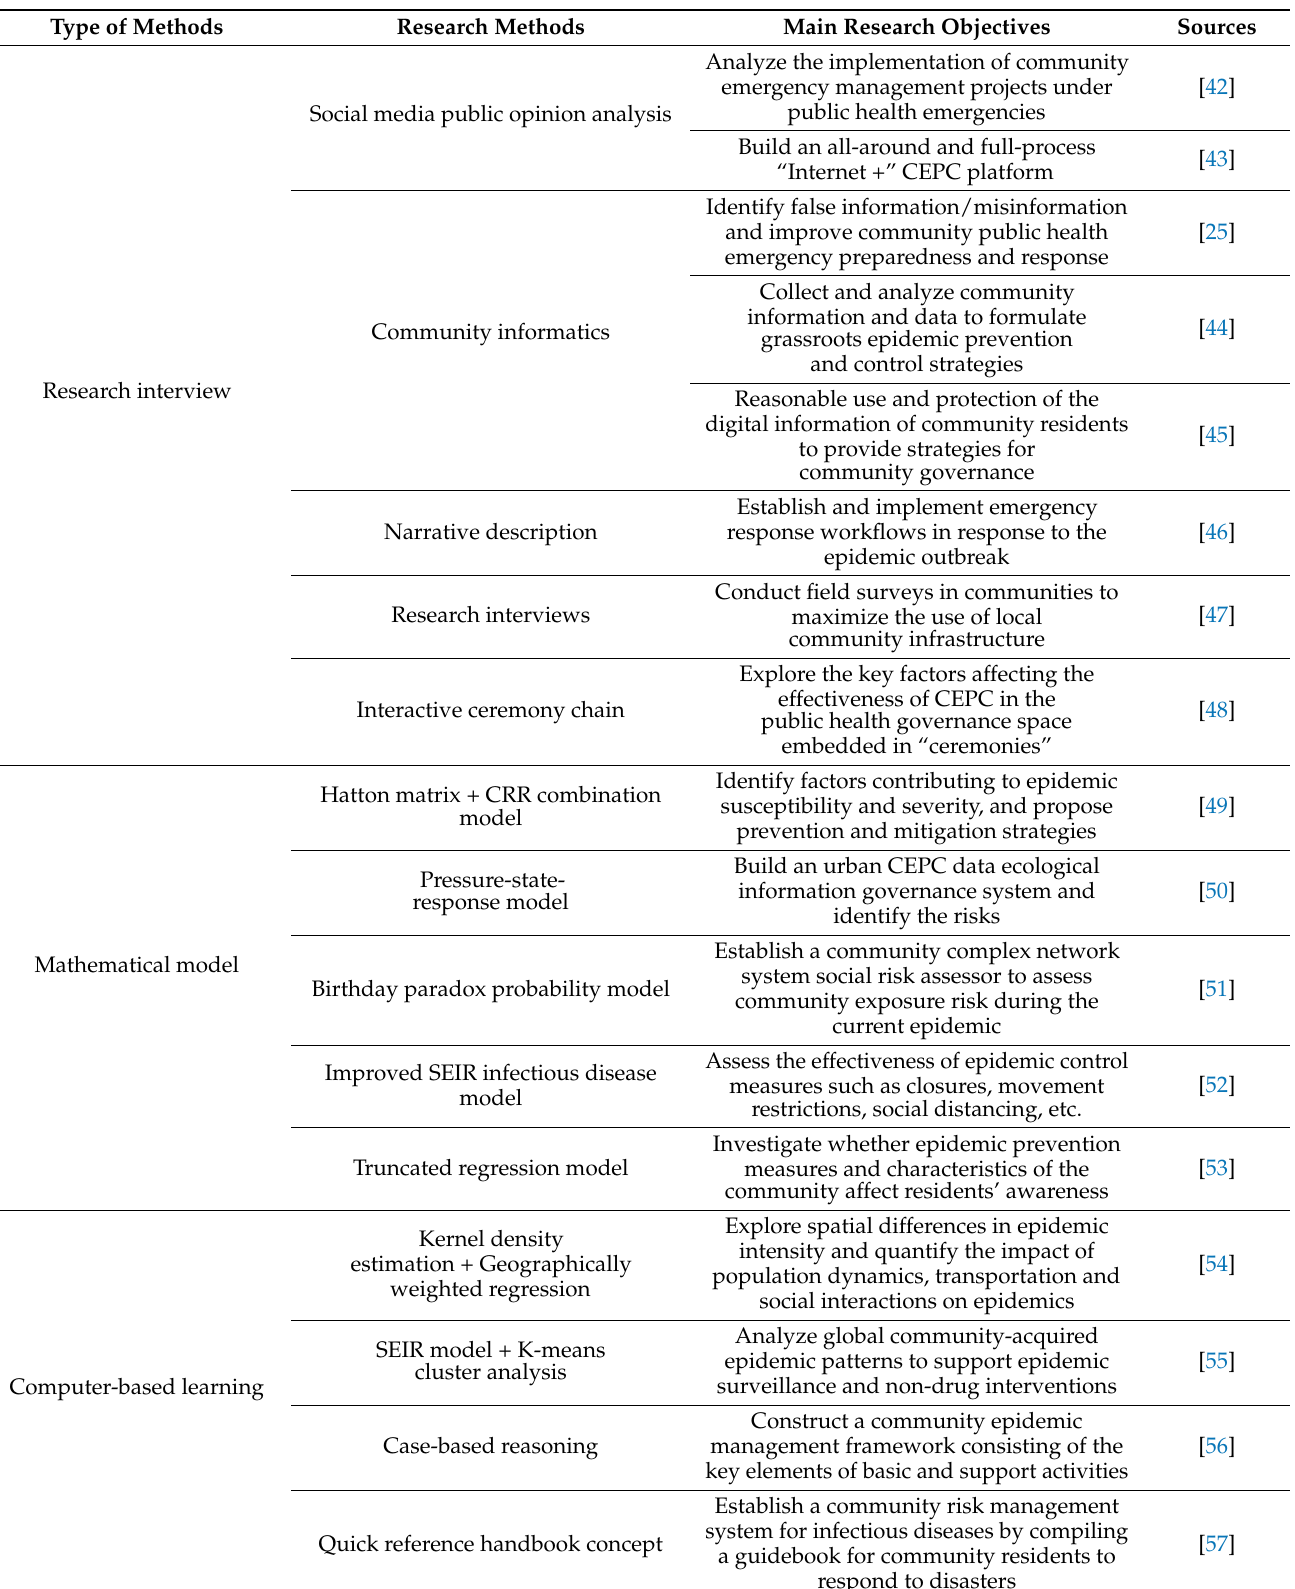
Table 1. Review on research methods of